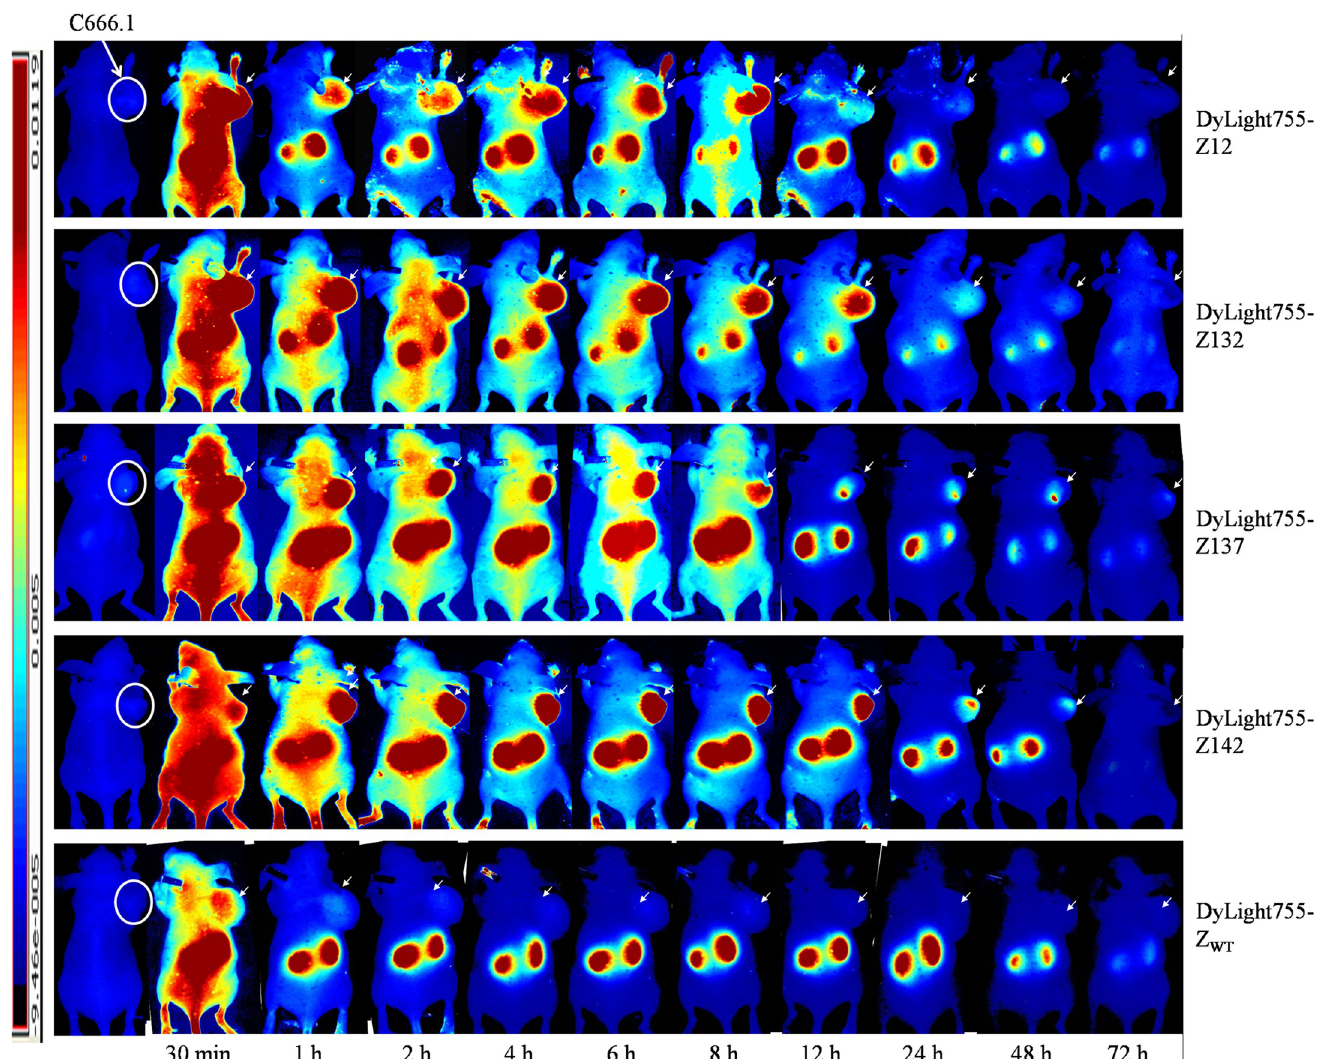
Fig 3. Tumor uptake of the affibody molecules by subcutaneous xenografts. Mice bearing C666-1 xenografts (circles) were intravenously injected with Dylight755-labeled affibody molecules followed by dynamic scanning with in vivo NIR system. The unselected original affibody scaffold molecule Z WT with no binding affinity to LMP-2 served as a control. The fluorescence signal in xenografts were detectable at 0.5 h post-injection. Subsequently, the fluorescence intensity in the tumor gradually increased until 4~ 6 h post infection and then decreased gradually. The fluorescence signal of Z137 and Z142 at tumor sites persisted for at least 48 h. In addition, affibody accumulation in the kidneys was observed because the small size of affibody proteins are cleared via renal filtration. No tumor-specific fluorescence signal was observed in the xenografts in the mice injected with Dylight755-labeled Z WT molecules.